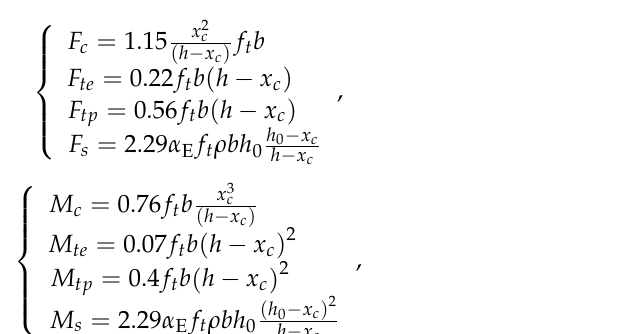
where: F c and M c are the combined force and bending moment of the beam in the com- pression zone; F te and M te are the combined force and bending moment of the beam in the elastic tension zone; F tp and M tp are the combined force and bending moment of the beam in the plastic tension zone; F s and M s are the combined force and bending moment of the main rebars; x c is the relative height of compression zone; b is the width of the beam section; h is the height of the beam section; h 0 is the effective height of the beam section; α E is the section conversion factor; ρ is the reinforcement rate of the main rebars.